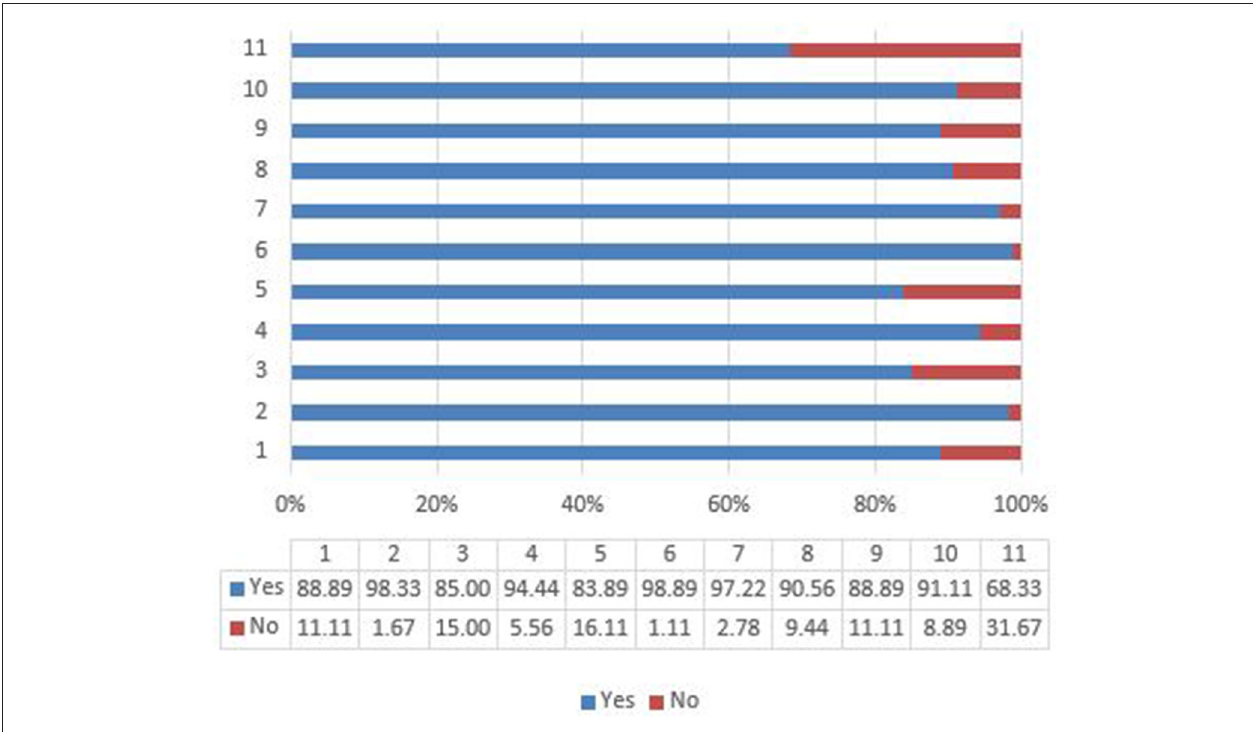
FIGURE 1 | Preventive